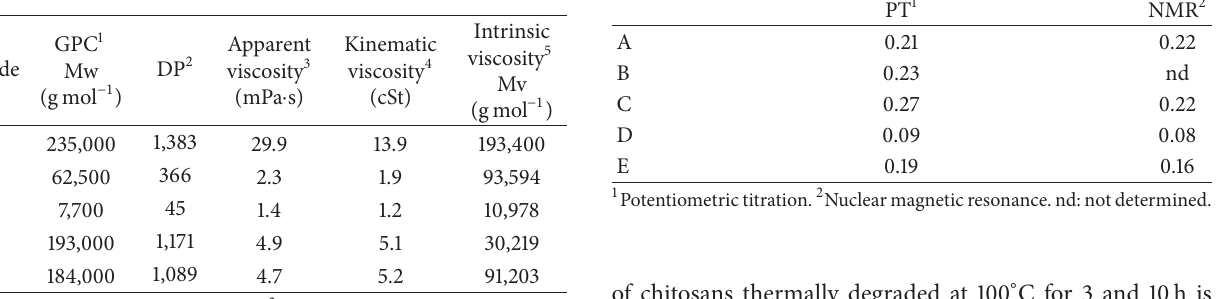
Table 4: Average molar mass (Mw), degree of polymerization, kinematic and apparent viscosties and viscosity average molar mass (Mv) of chitosans obtained by thermal treatment and alkaline deacetylation.